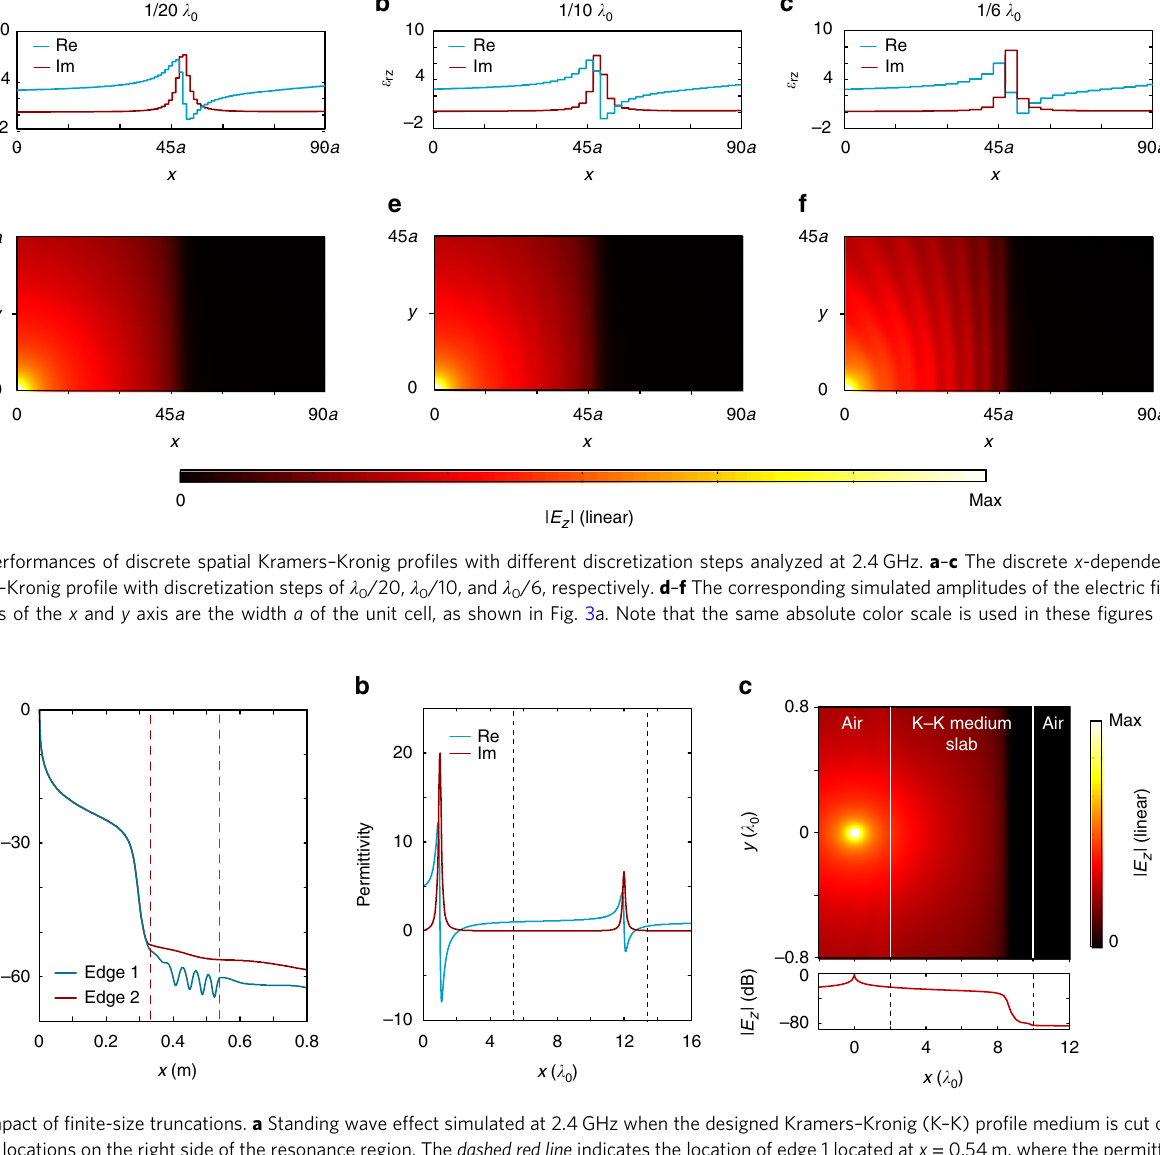
Fig. 8 Impact of fi nite-size truncations. a Standing wave effect simulated at 2.4 GHz when the designed Kramers – Kronig (K – K) pro fi le medium is cut off at different locations on the right side of the resonance region. The dashed red line indicates the location of edge 1 located at x = 0.54 m, where the permittivity is 3.3. The dashed blue line indicates the location of edge 2 at x = 0.33 m, where the permittivity is 1. The solid blue and red curves show the simulated standing wave effects due to edges 1 and 2, respectively. b Construction of a K – K pro fi le medium slab for incidences from outside. The left dashed line indicates the front edge of the slab located at x = 5.45 λ 0 , where ε r = 1. The right dashed line indicates the back edge of the slab located at x = 13.45 λ 0 , where ε = 0.55. The thickness of the designed slab is 8 λ – K pro fi le medium slab described in b when a point source is placed 2 λ r 0 . c Simulated results for the K